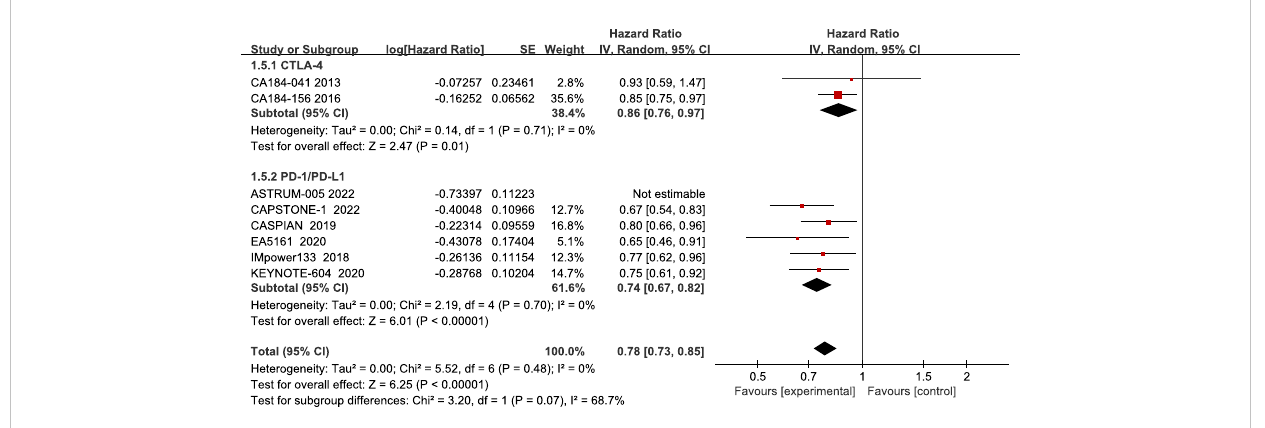
FIGURE 5 Forest plot of PFS comparison between ICIs combined with chemotherapy and chemotherapy alone and subgroup